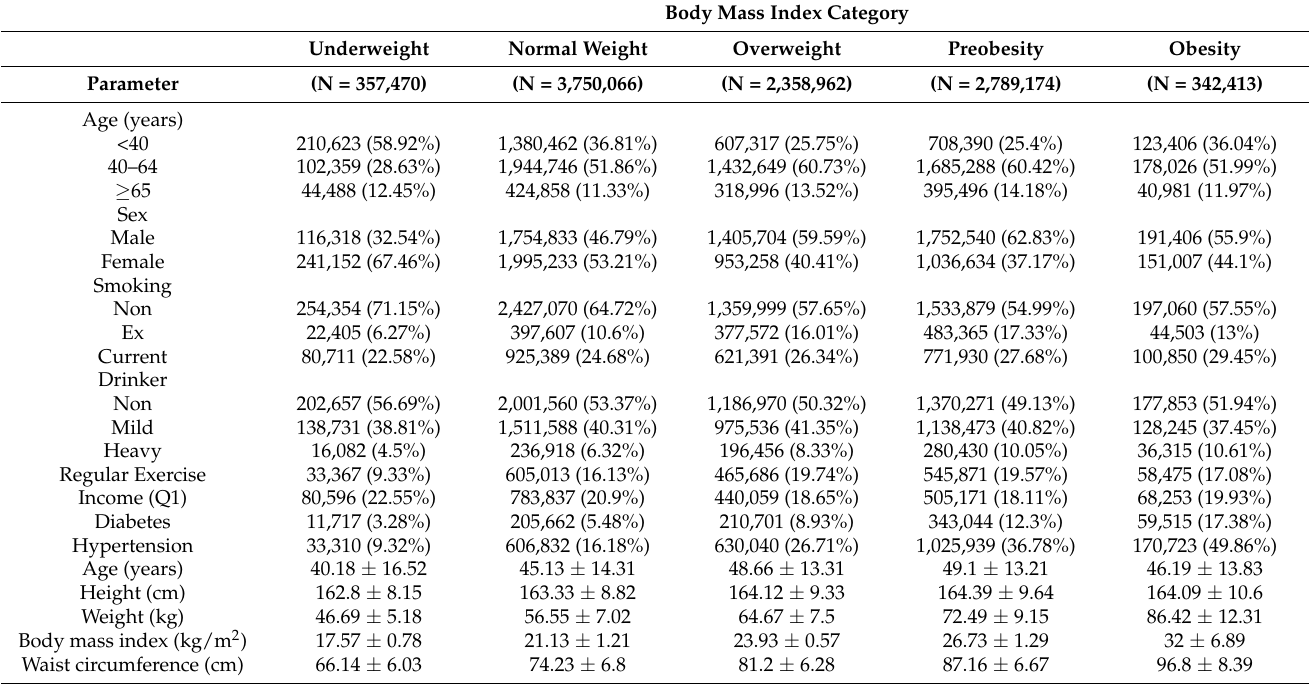
Table 1. General characteristics of the participants according to WHO recommendation of body mass index for the Asian population (underweight ≤ 18.5 kg/m 2 , normal weight = 18.5–23 kg/m 2 , overweight = 23–25 kg/m 2 , preobesity = 25–30 kg/m 2 , obesity ≥ 30 kg/m 2 ). Body Mass Index